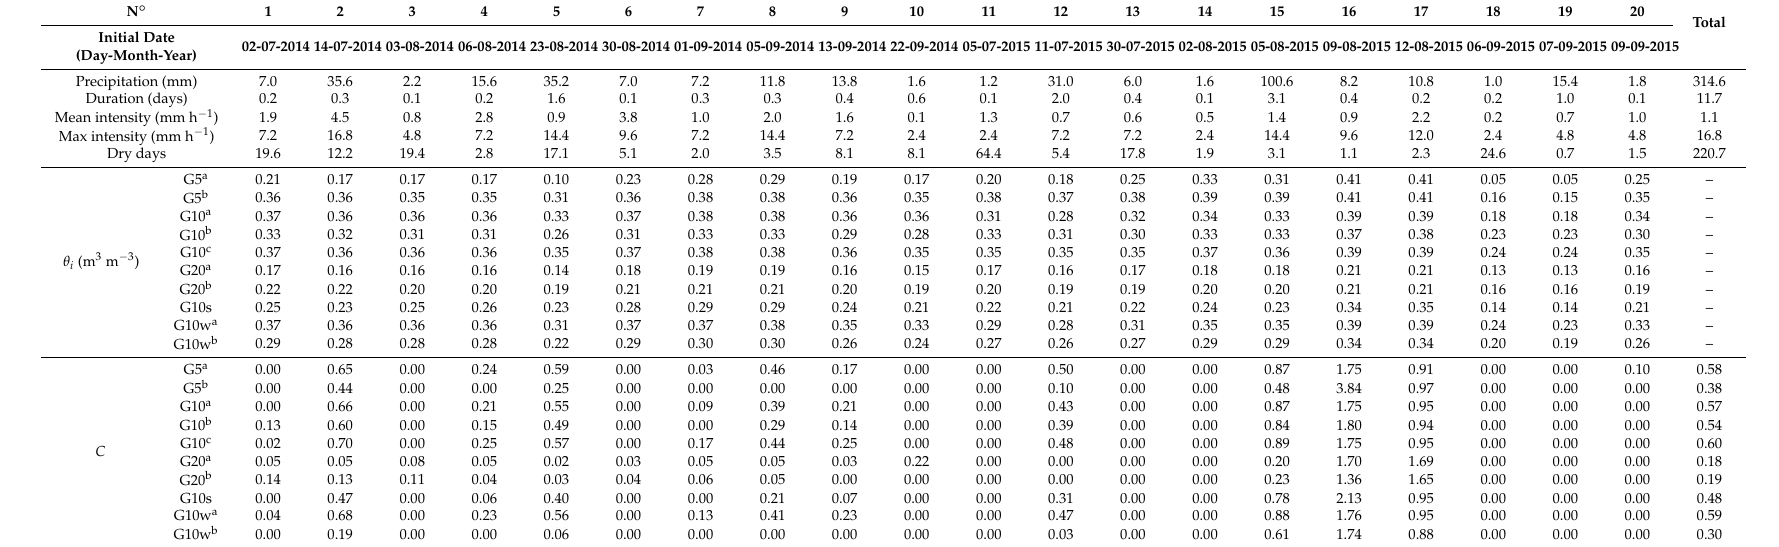
Table 6. Hydrological information of each precipitation event during the 2014 and 2015 winter